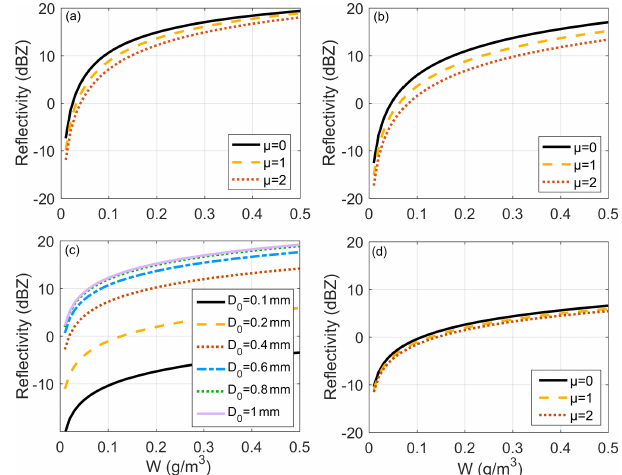
Figure 3. Impact of PSD parameters on radar reflectivity for cloud ice. PSD parameters constrained by Eqs. (7)–(9); reflectivity vari- ation obtained when µ was 0, 1, and 2 and (a) temperature T was − 20 ◦ C and (b) T was − 60 ◦ C. PSD parameters varied indepen- dently; reflectivity variation obtained by a (c) D 0 of 0.1, 0.2, 0.4, 0.6, 0.8, and 1mm with a µ of 1 and (d) µ values of 0, 1, and 2 with a D 0 of